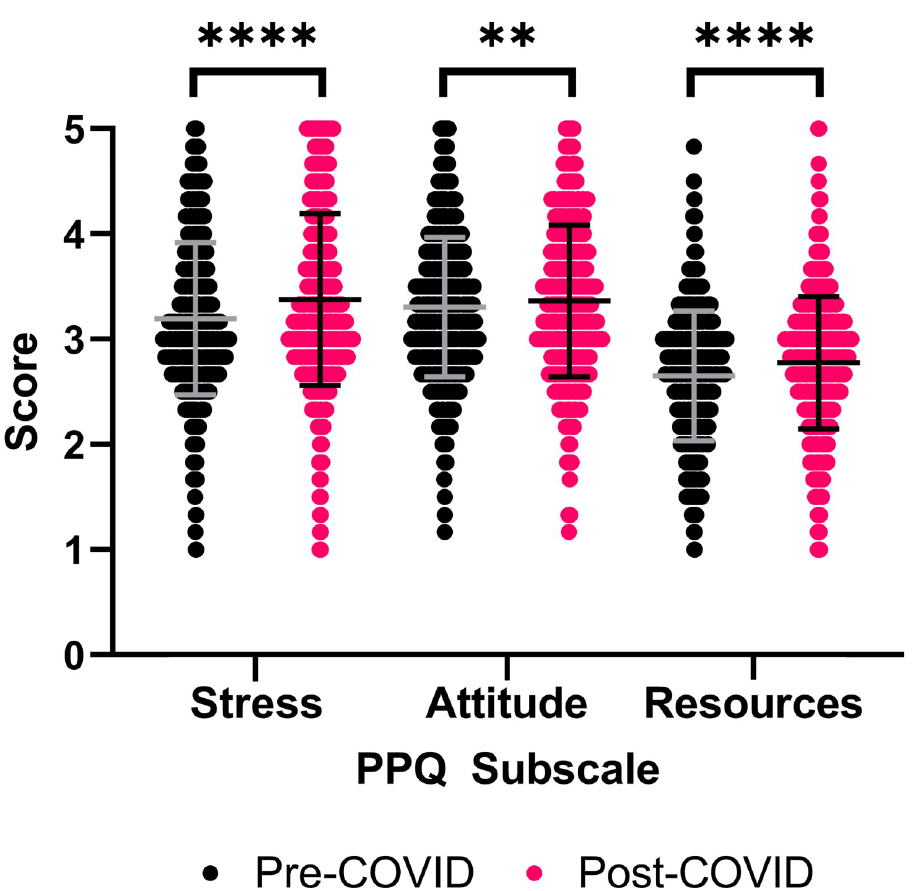
Fig 1. Publication pressure questionnaire subscale scores pre- and post-COVID-19 pandemic onset. Paired Student’s t-test with Bonferroni correction. ��� = 0.0011, ���� P � 0.0001. N = 1020.